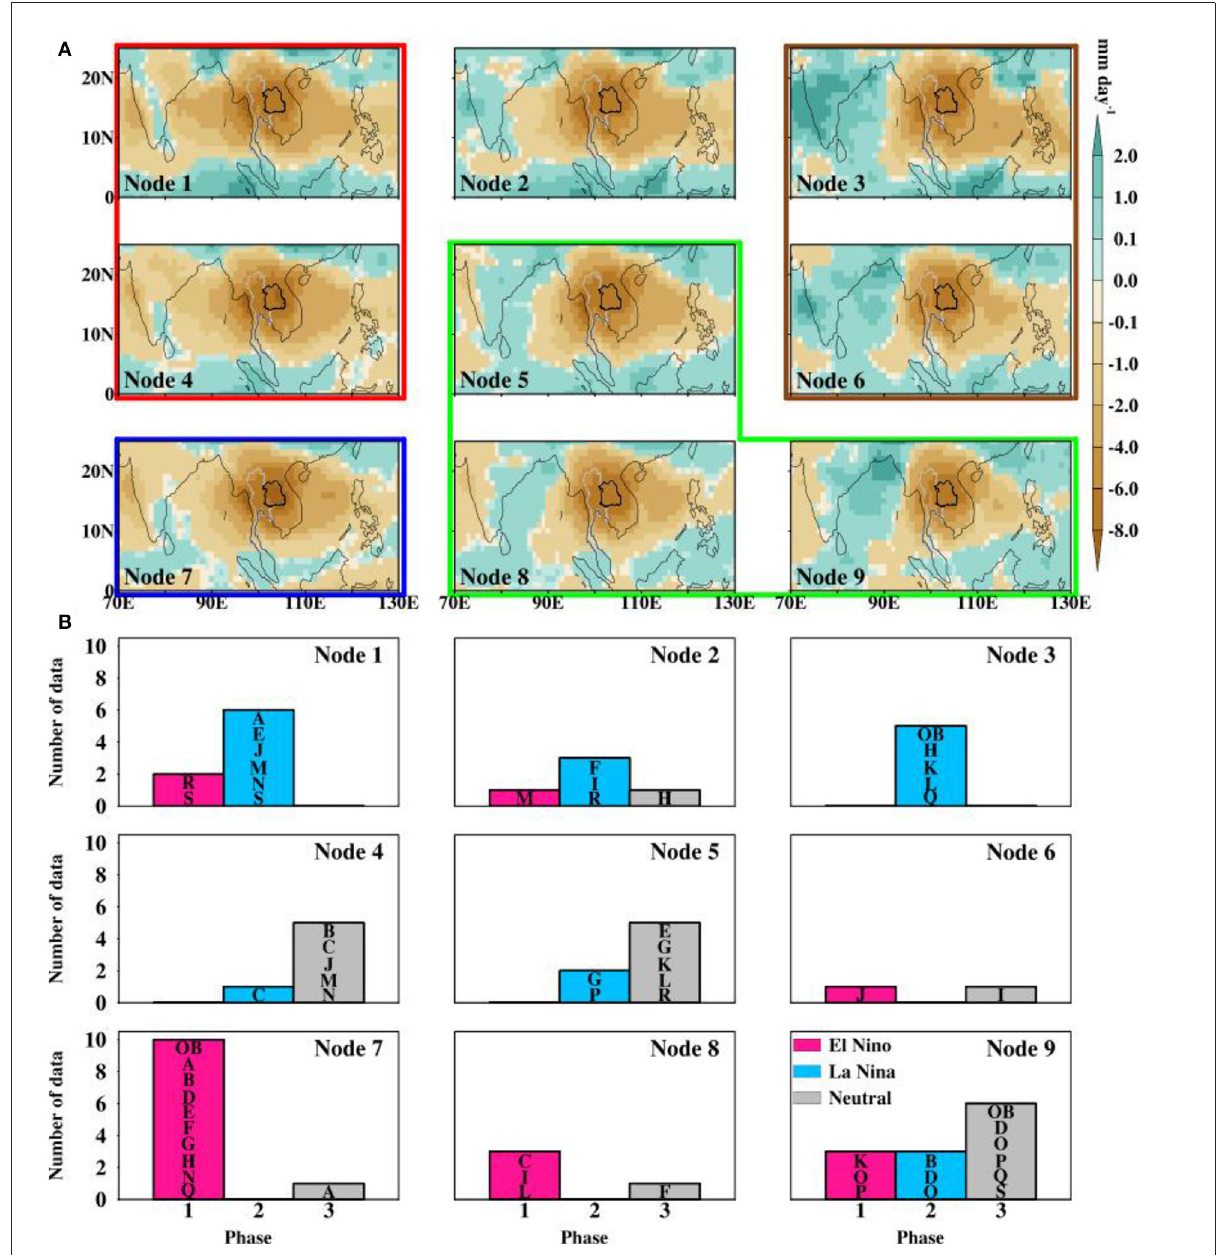
FIGURE9 (A) The 3 × 3 SOMs distribution of dry spells composite rainfall anomalies over NE Thailand in the ENSO condition during inactive BSISO phase [top panels; (A) ], and the frequency distribution of data for each ENSO phase in the SOMs nodes [bottom panels; (B) ]. The alphabet tag in each ENSO bar represents the code of the models that make up the bar (Table